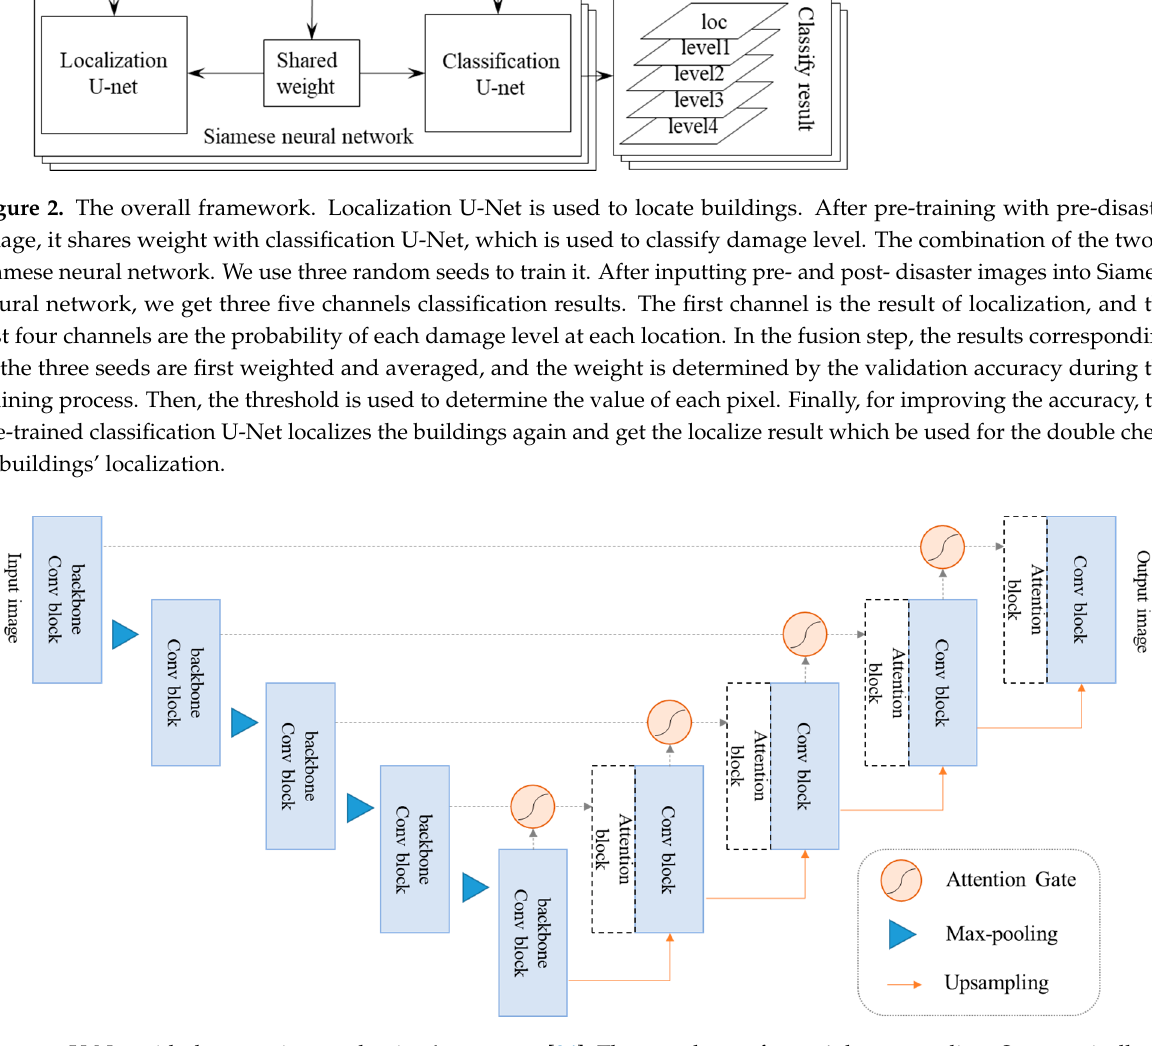
Figure 3. U-Net with the attention mechanism’s structure [34]. The encoder performs 4 downsampling. Symmetrically, its decoder upsamples 4 times to restore the features to the original image resolution. The attention gate is placed at the end of the skip connection.